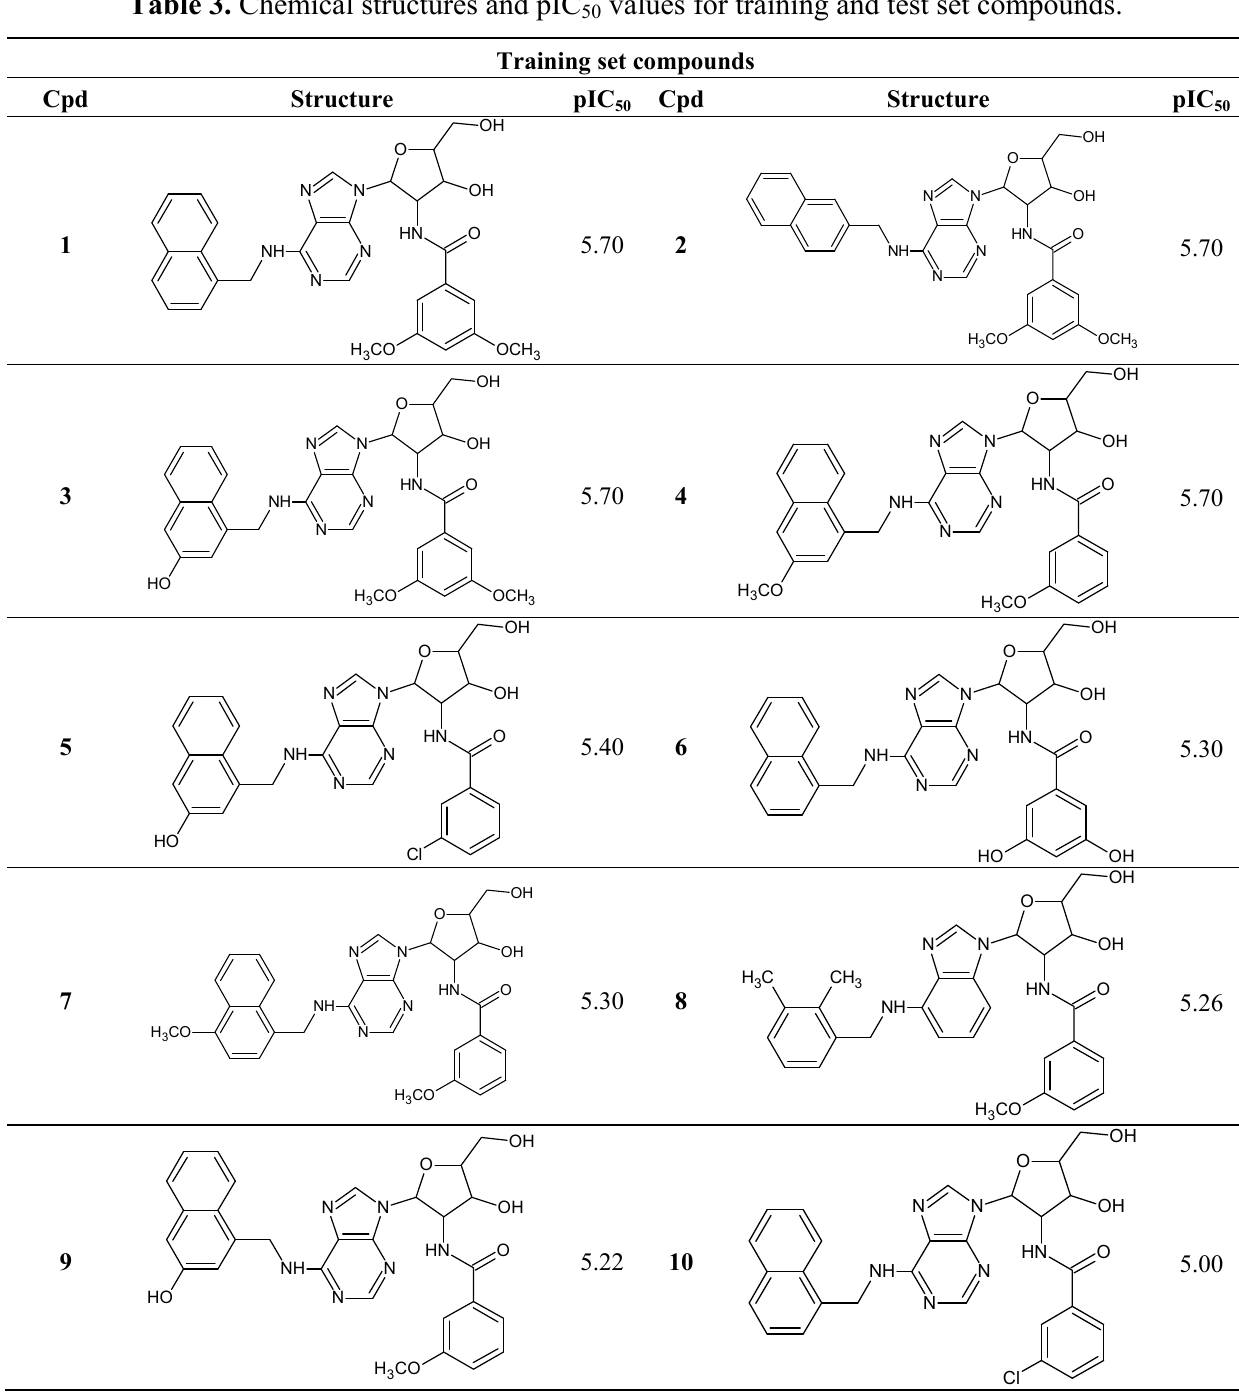
Table 3. Chemical structures and pIC